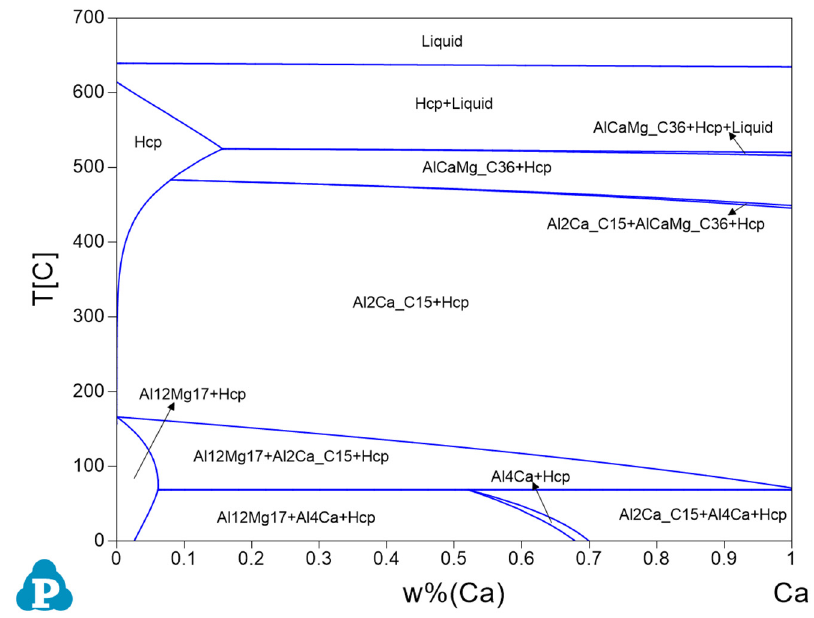
Figure 2. X-ray diffraction spectra of the as-cast alloys.